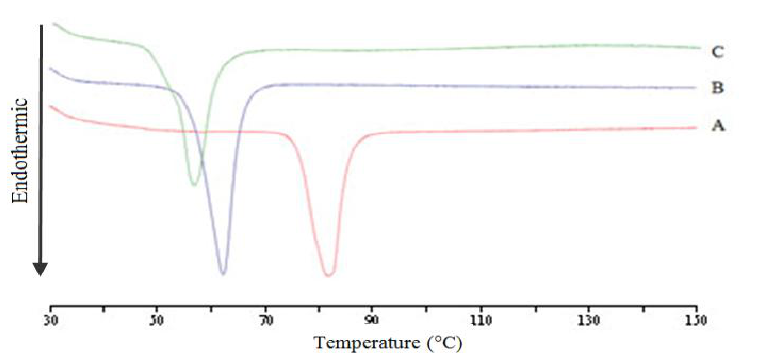
Figure 2. Elastic modulus of A. Ibuprofen, B. Stearic acid, C. Ibuprofen-stearic acid weight ratio of 4:6, D. 5:5, and E. 6:4.